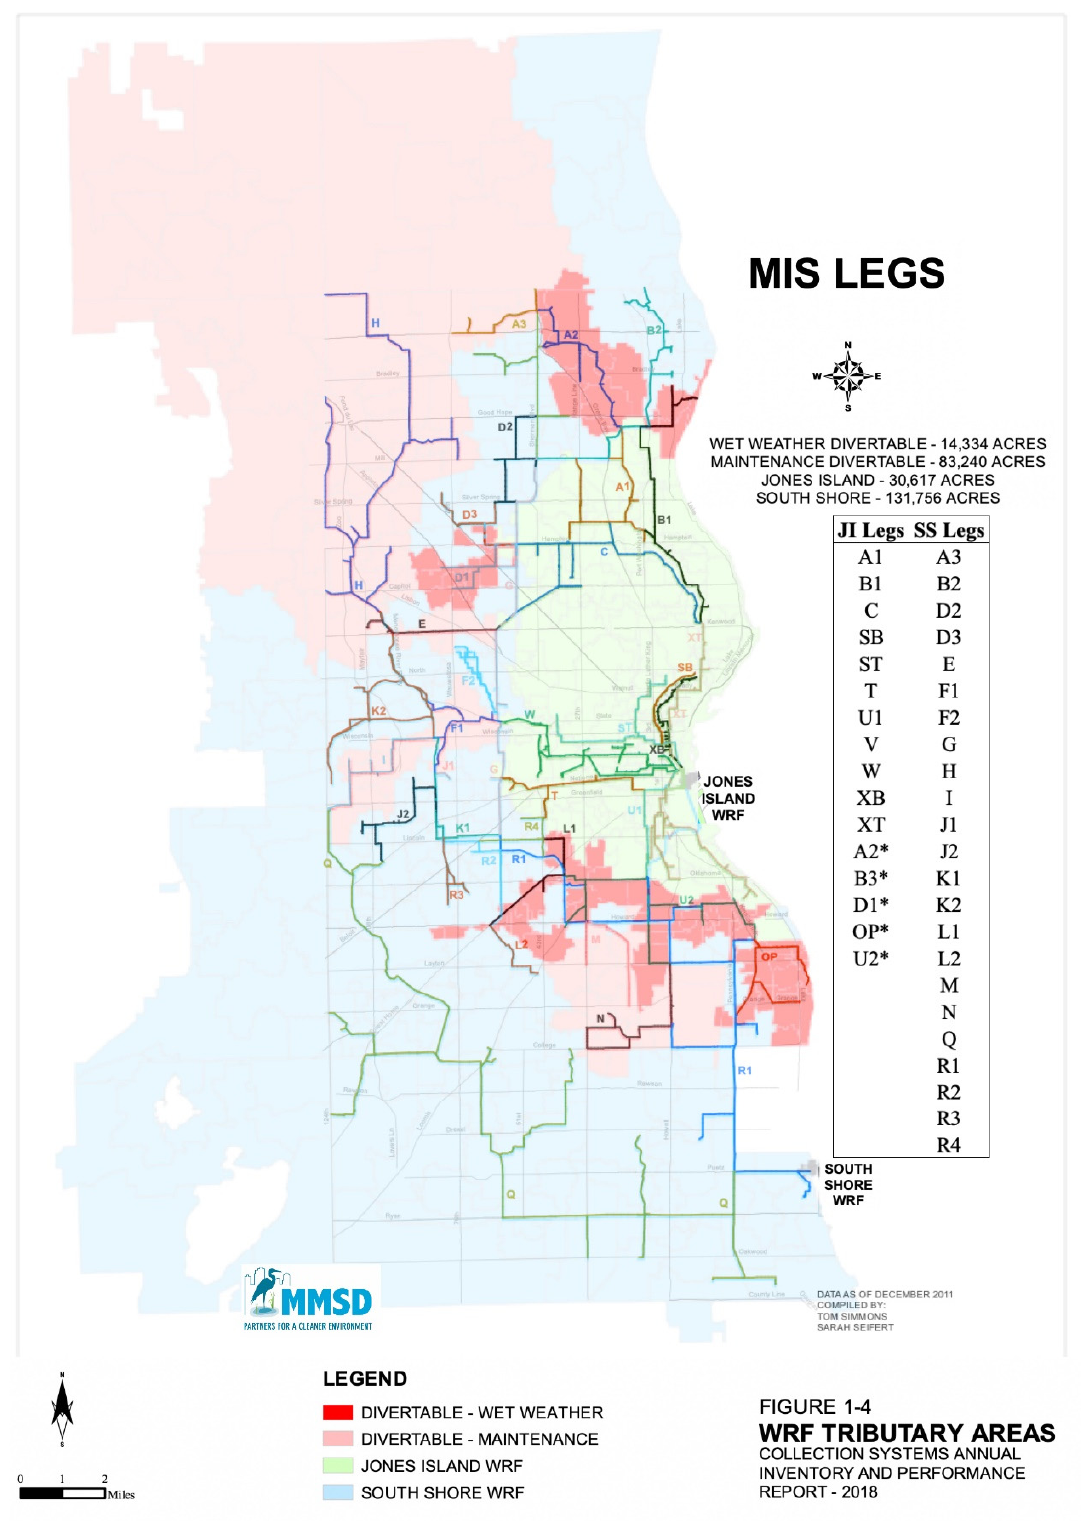
Figure 1. MMSD sewer tributary areas consisting of 162,373 acres of land divided between JI and SS sewer systems. Collectively 131,756 acres goes to SS WWTP (blue), and 30,617 acres goes to JI WWTP (green). A total of 14,334 acres of JI service area can be diverted to SS under high flow conditions (dark red). Divertible maintenance pipes are indicated by light red. The legend indicates which legs (labeled on map) flow to which WWTP. Legs with an * indicate legs that are diverted to SS under high flow conditions and corresponds to 11% of the SS service area. Map provided by